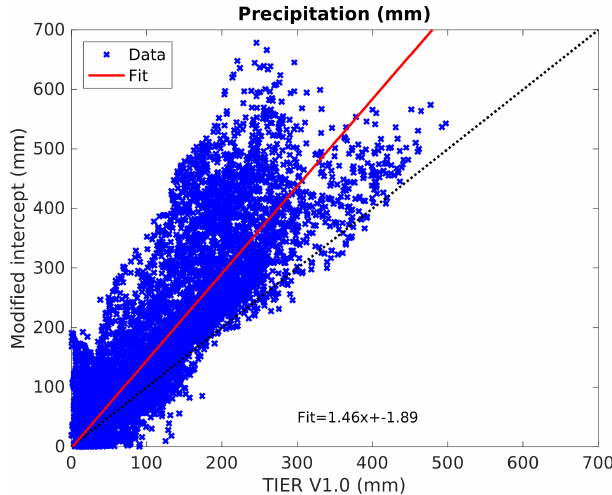
Figure 8. Comparison of precipitation (mm) estimates using ˆ β 0 in Eq. (15) versus TIERv1.0 which uses ˆ µ b